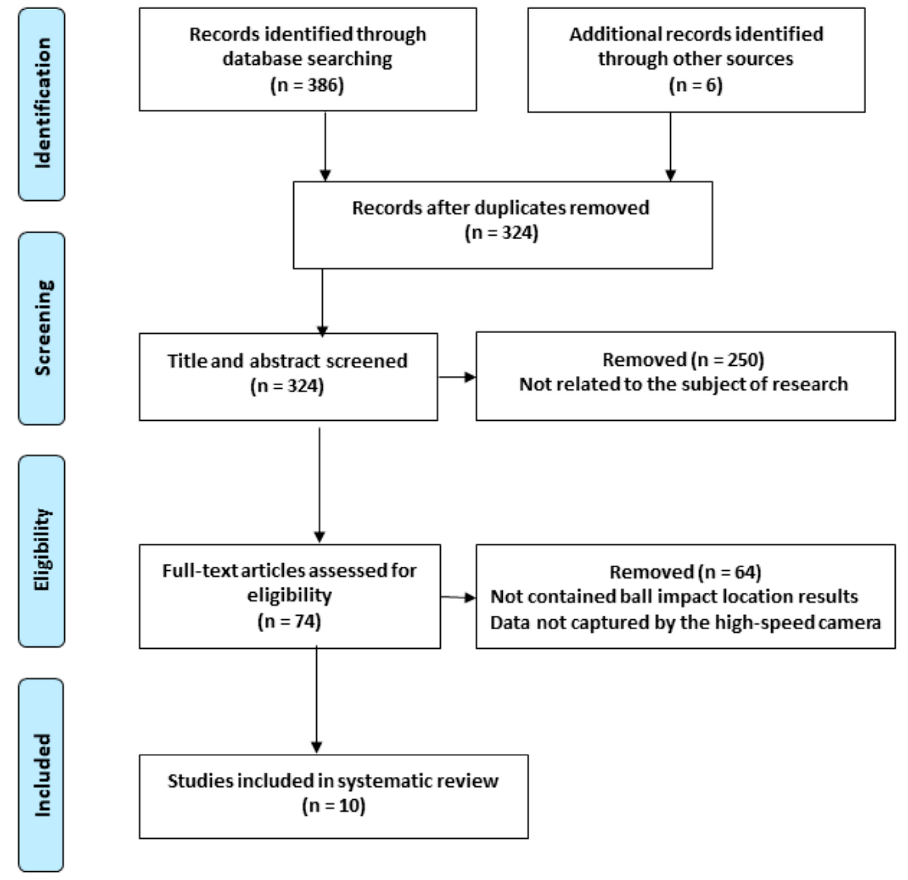
Figure 2. The flow chart of the systematic approach to the retrieval articles relevant to the ball impact location within the tennis serve. Table 1. Characteristics of the chosen studies for systematic review.